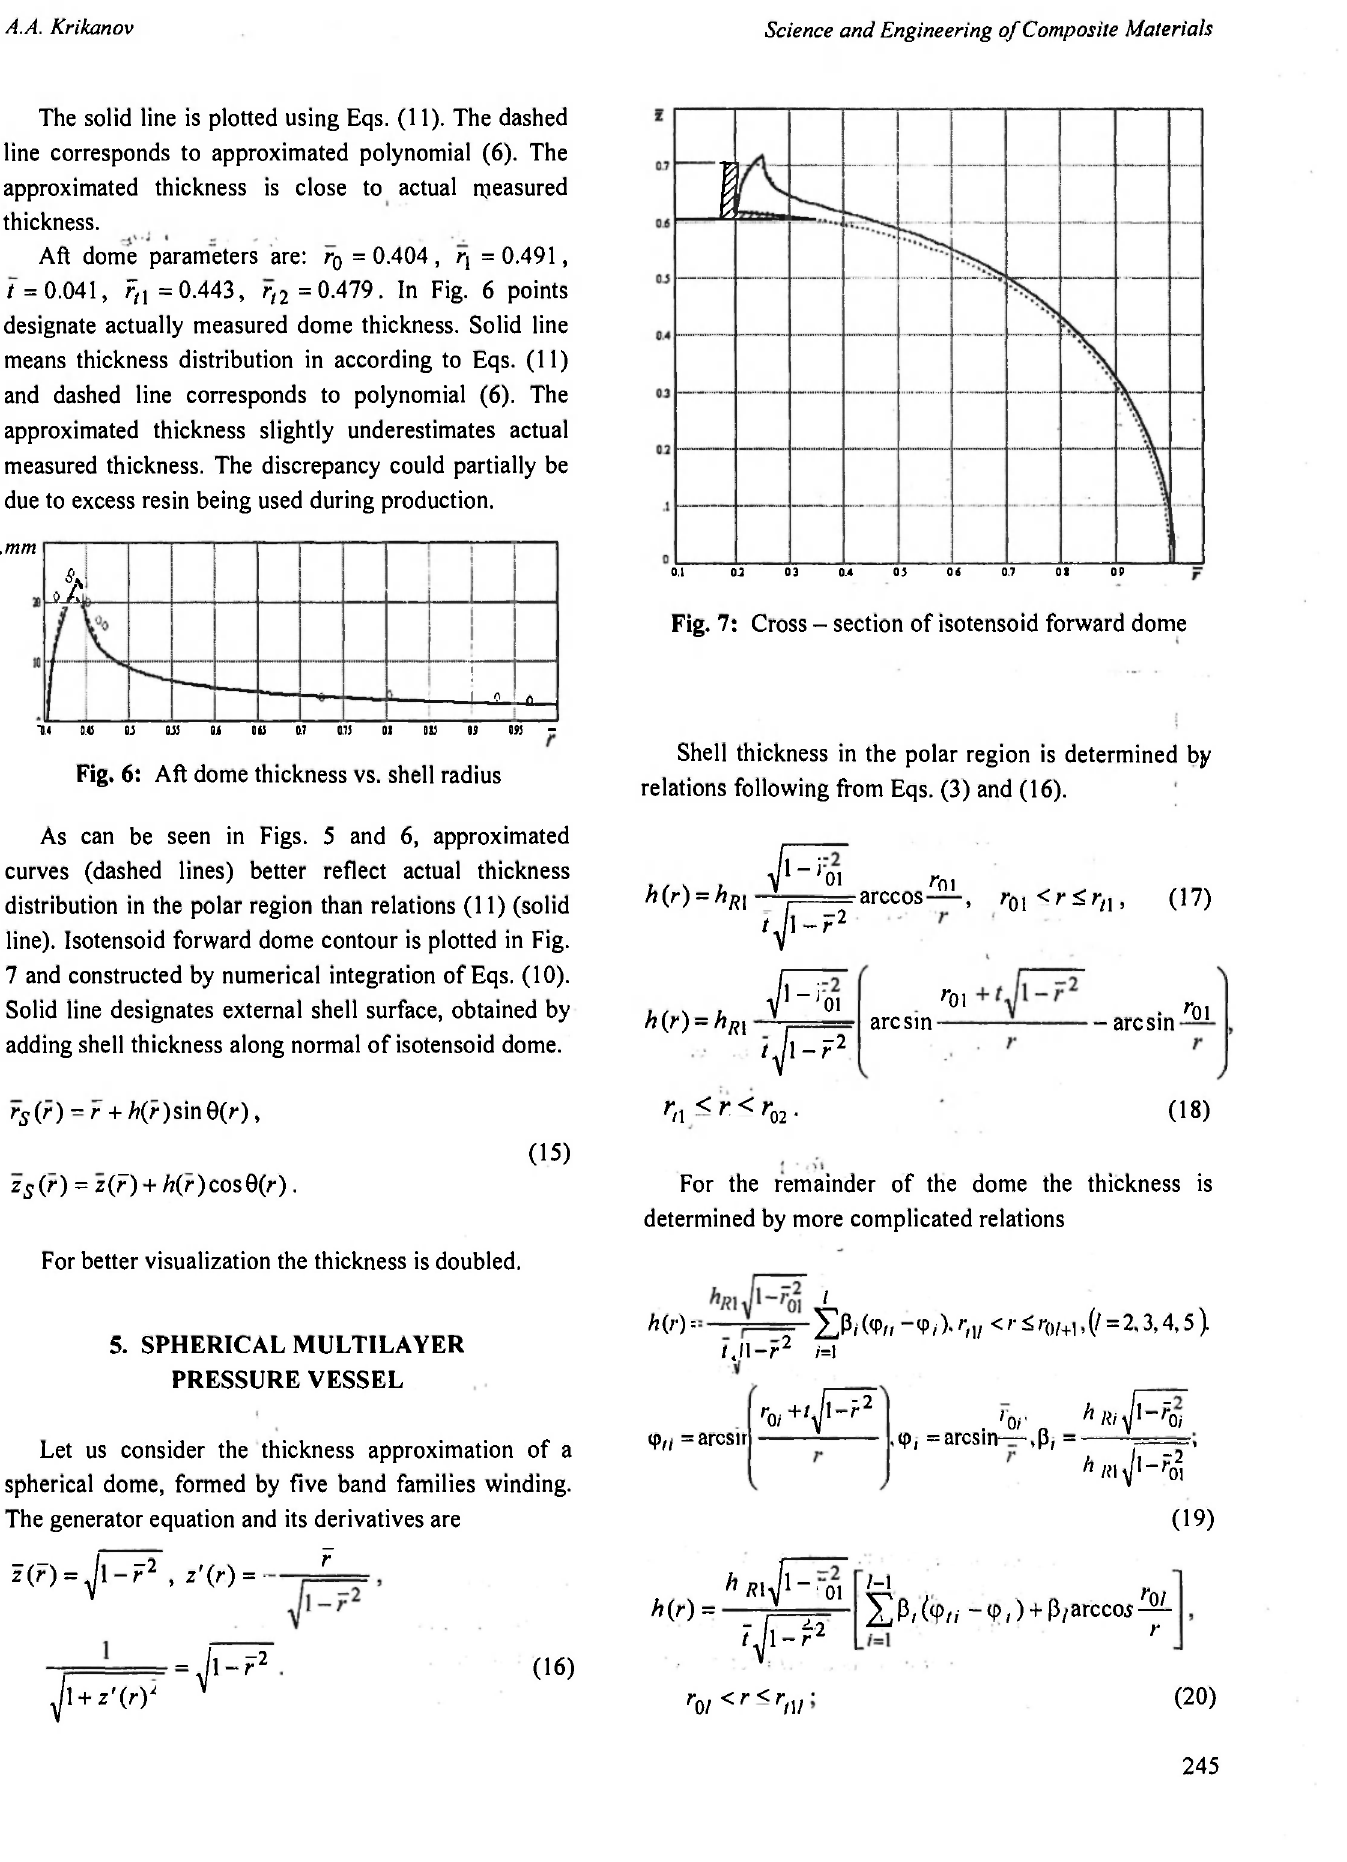
Fig. 7: Cross - section of isotensoid forward dome